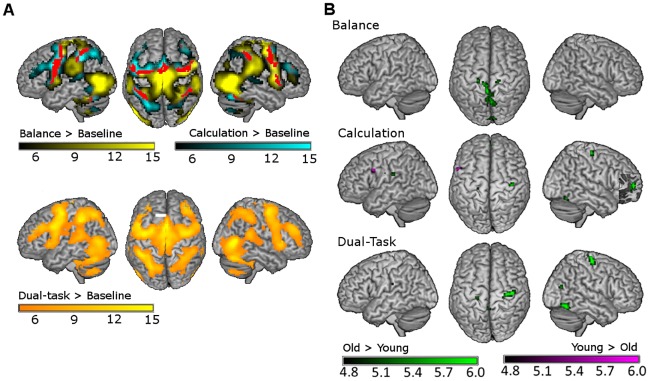
A: Mean brain activation patterns during balance and calculation (upper panel), and dual-tasking (lower panel) as compared with baseline. Significantly activated voxels during balance, calculation and dual-tasking, i.e. the main task effects, are shown in yellow, cyan and orange colors, respectively. Voxels shown in red in the upper panel are those revealed by conjunction analysis (balance AND calculation) and therefore represent areas not specific for a single-task. B: Age-related differences during balance, calculation, and dual-tasking. Voxels with higher activation in old compared with young adults are shown in green, whereas voxels with higher activation in young compared with old adults are shown in purple. Statistical significance was set at p < 0.05, FWE corrected for multiple comparisons.